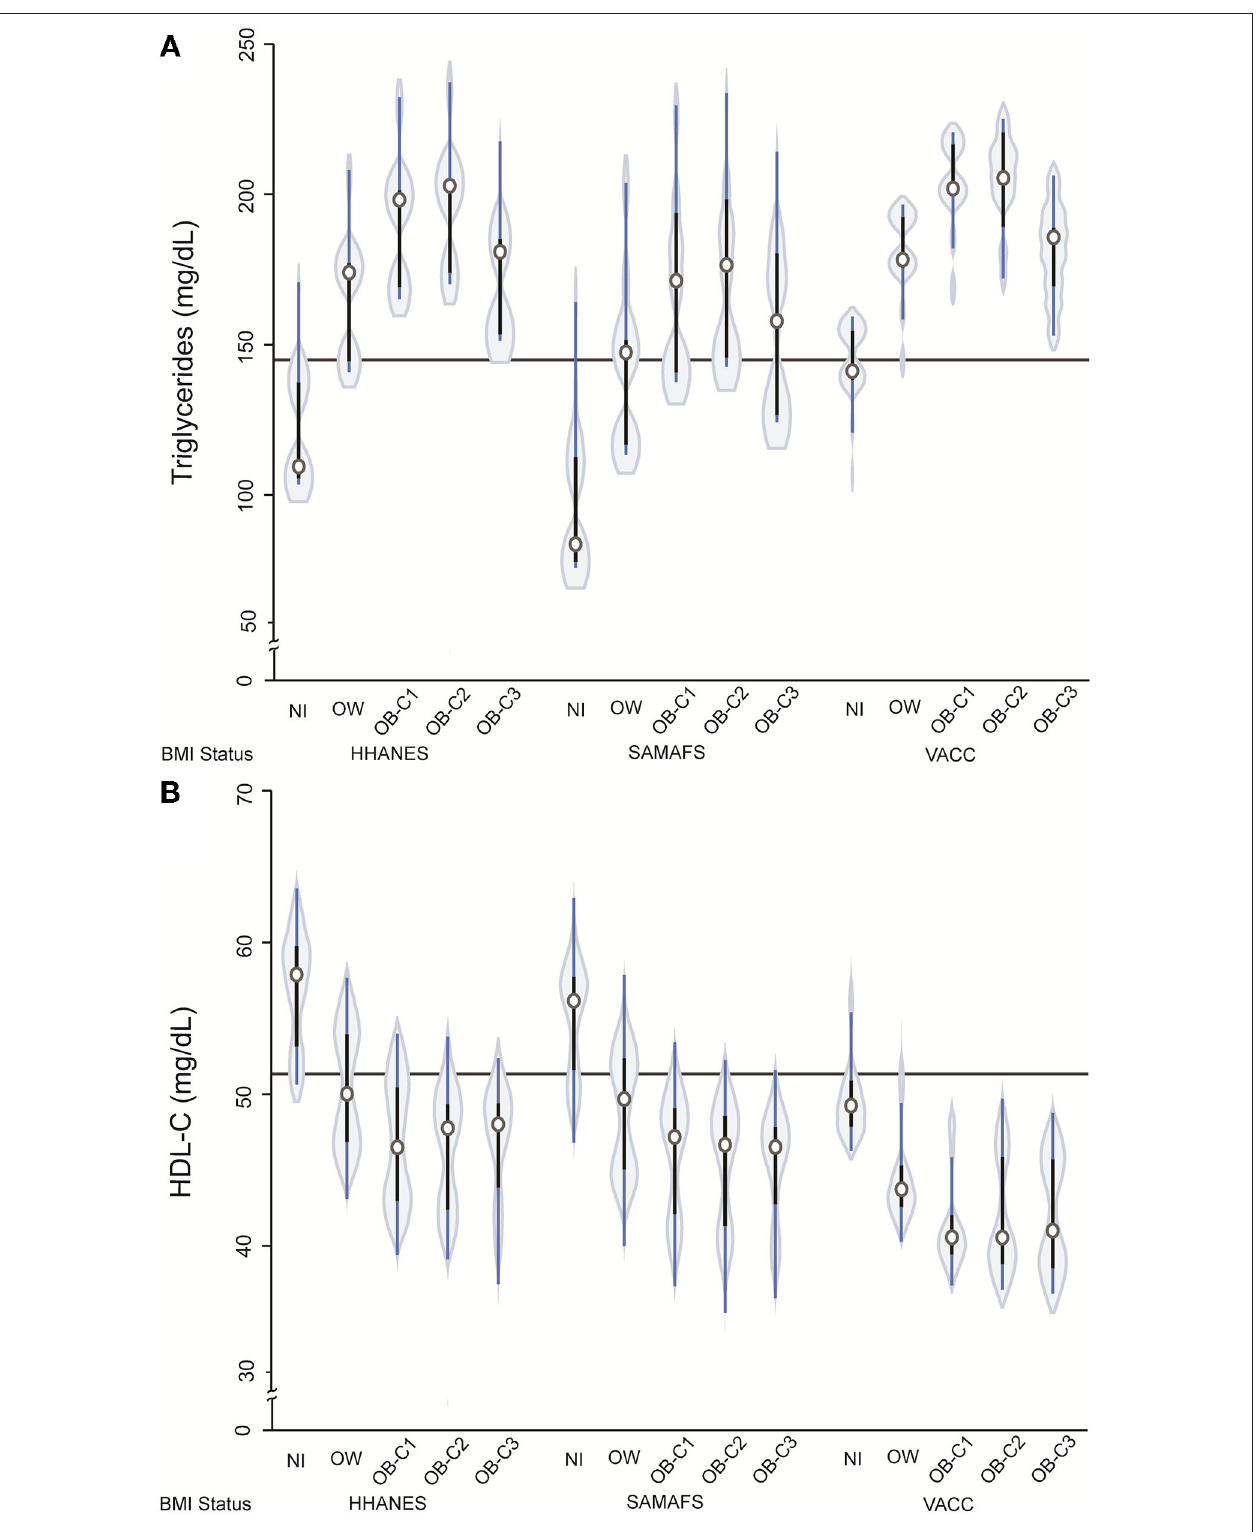
FIGURE 4 | Violin plots showing relationship between triglycerides (A) and HDL-C (B) with BMI categories after adjusting for age, sex, cohort, and T2D status. The presence of diabetes was associated with higher triglyceride concentration [ b = 28.2 (se 12.3), p = 0.02] and lower HDL-C [ b = − 3.5 (se 0.9) p < 0.001]. The HDL-C showed interaction for VACC [ b = 2.2 (se 1.1) p = 0.042]. HHANES: The Hispanic component of NHANES 2018 cohort; SAMAFS, San Antonio Mexican American Family Studies; VACC, Valley AIDS Council Cohort. NW, normal weight; OW, overweight; OB-C1, obesity-category 1; OB-C2, obesity-category 2; and OB-C3, obesity category 3. The continuous horizontal line represents the mean value without